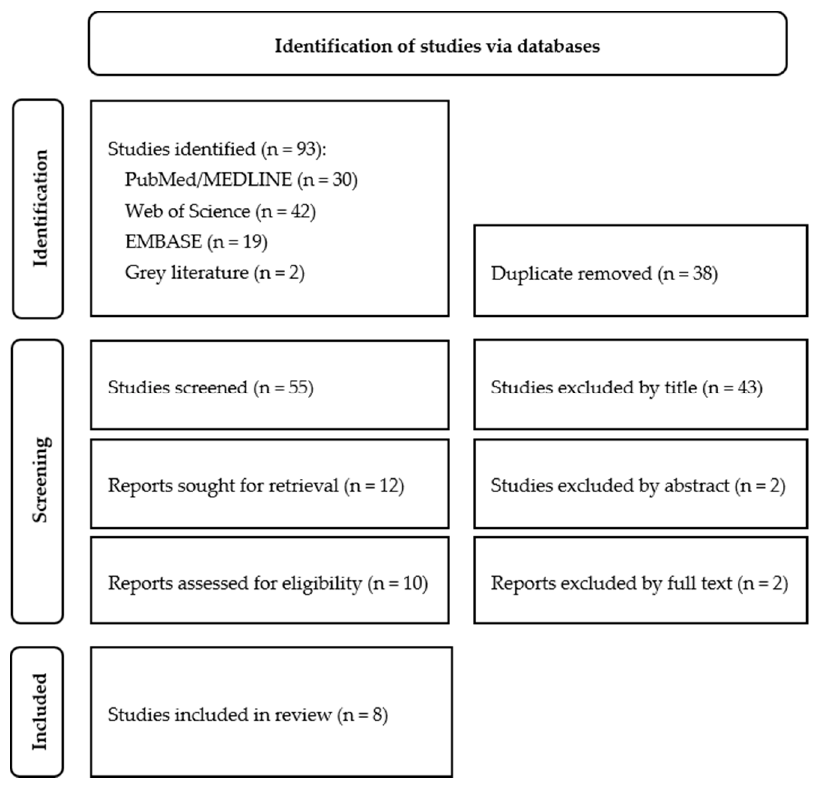
Figure 1. Flow chart of the systematic literature search according to PRISMA guidelines.